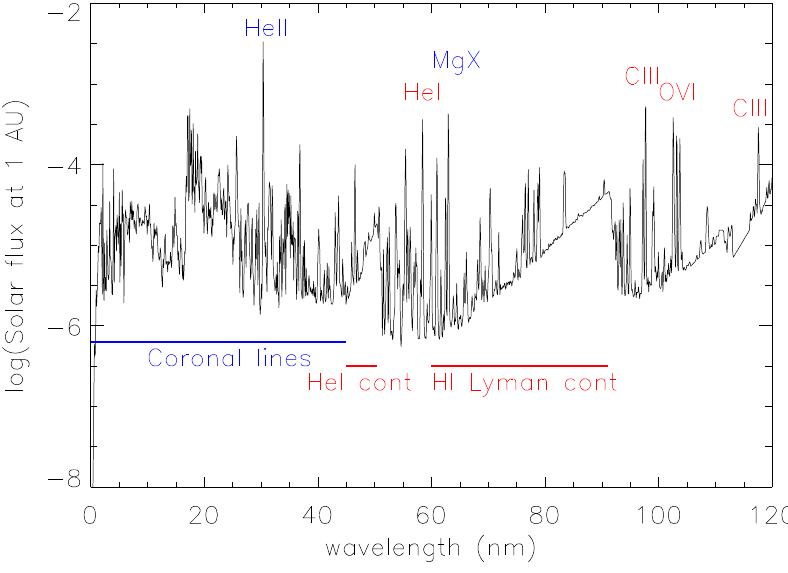
Figure 1. The Solar Irradiance Reference Spectrum (SIRS) obtained at solar minimum (March–April 2008). Flux units are Wm − 2 nm − 1 at 1 AU. Important emission lines formed in the corona (e.g., Mg X) and transition region (e.g., C III and O VI) and chromospheric continua are identified. Figure from Linsky et al with copyright permission